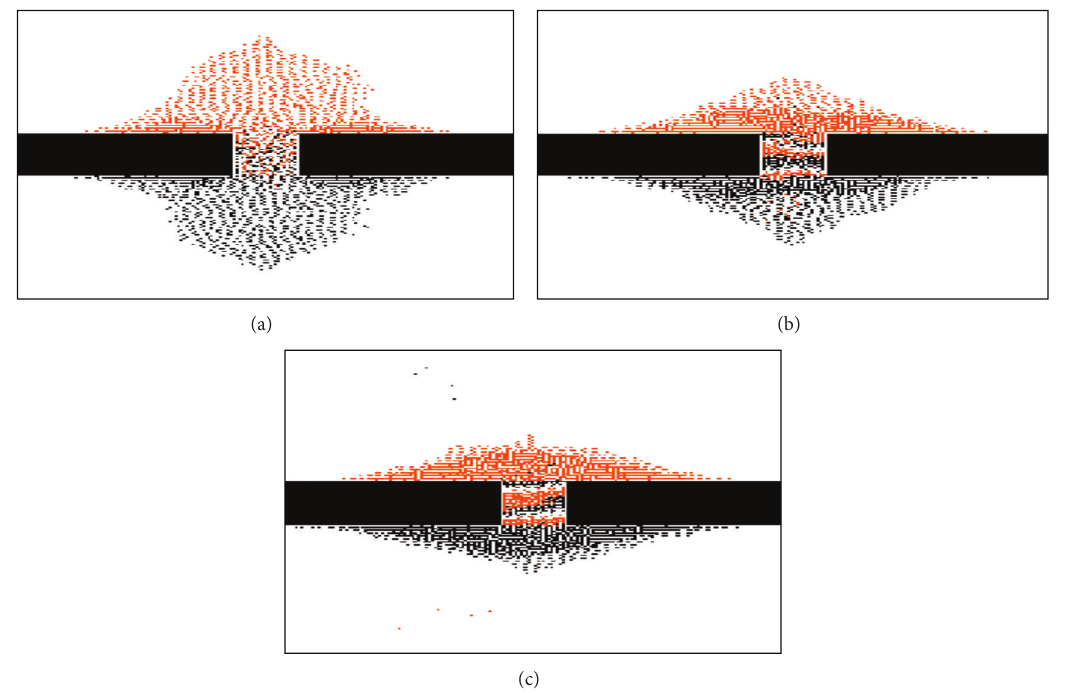
Figure 7: Simulations of evacuation for a bidirectional underpass.